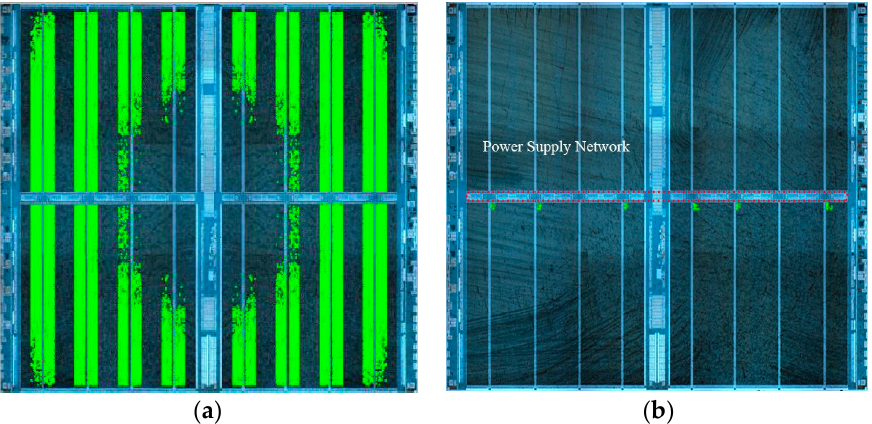
Figure 11. The sensitive areas of ( a ) SEE and ( b ) SESD for the SRAM.